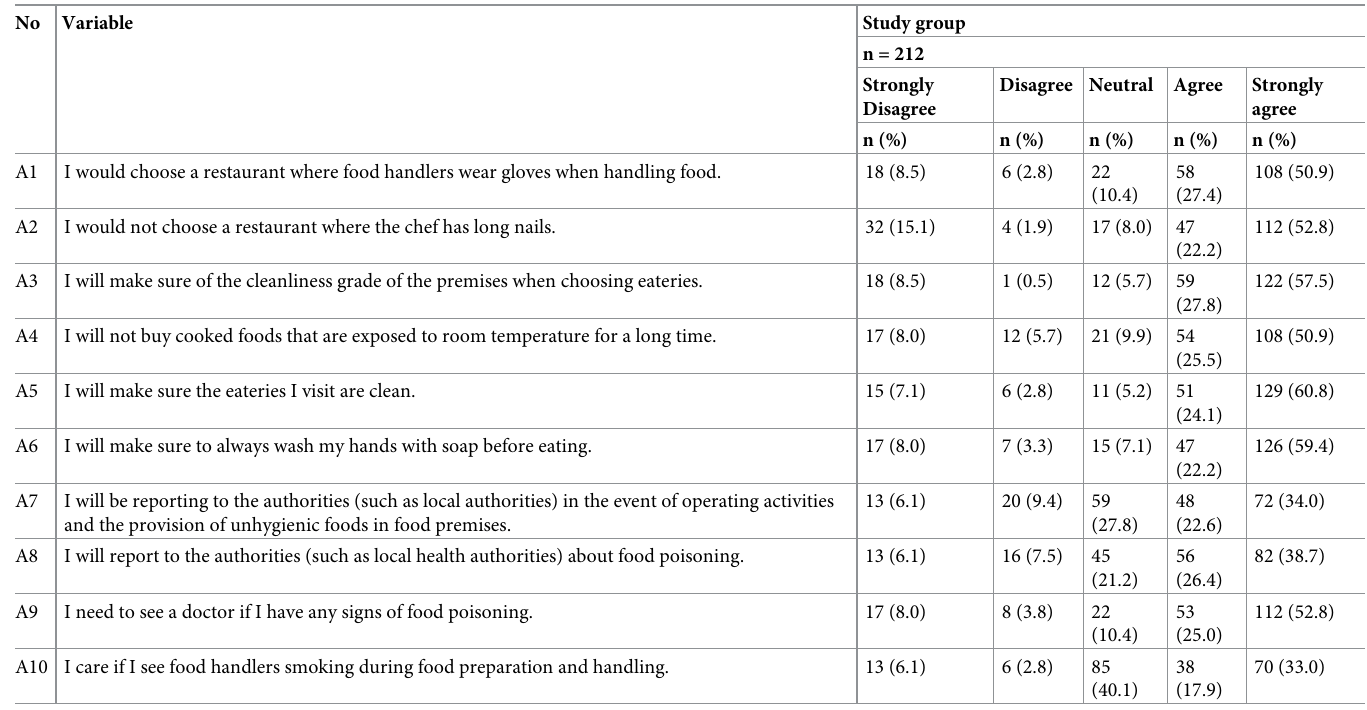
Table 11. Descriptive of attitude statements of food poisoning among the respondents (N =